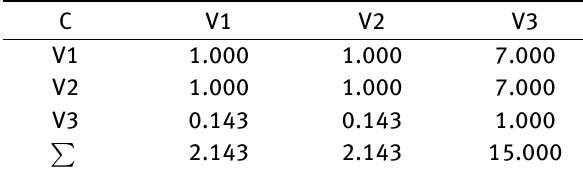
Table 6: Calculation of effectiveness in accordance with processing time.